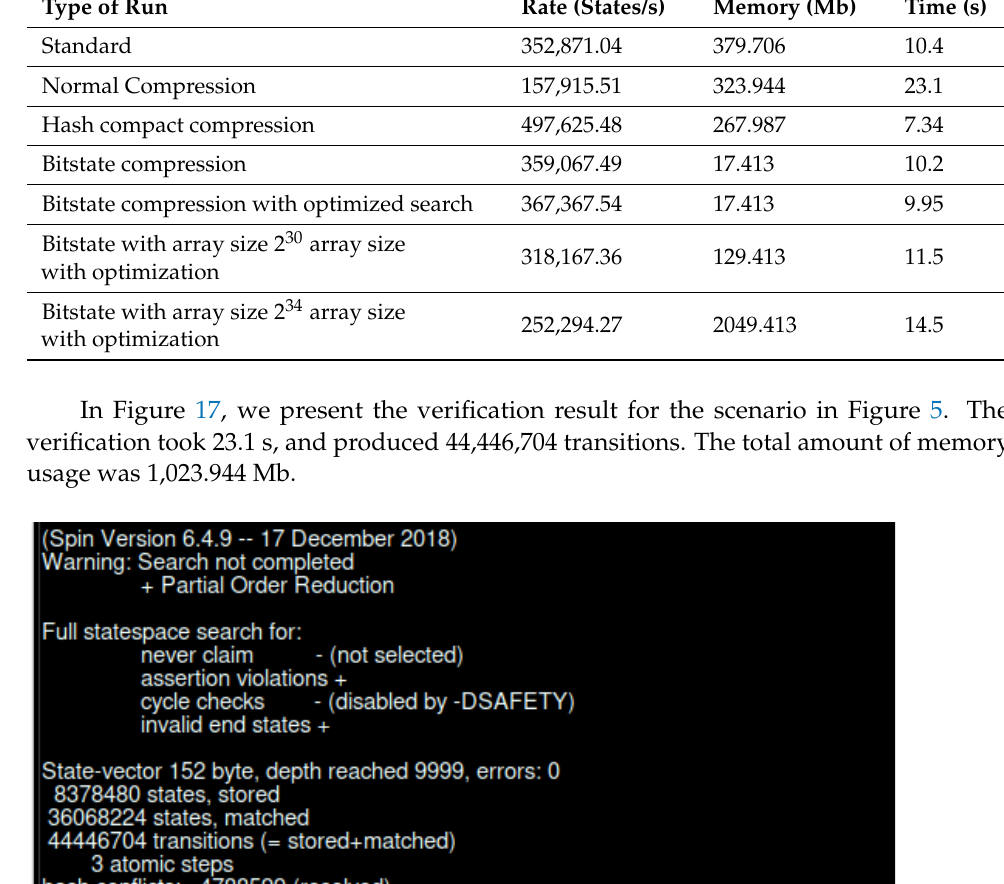
Table 4. Compression effect on the simulation results.